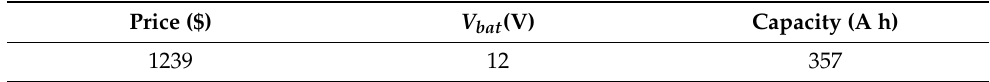
Table 3. Specification of the battery